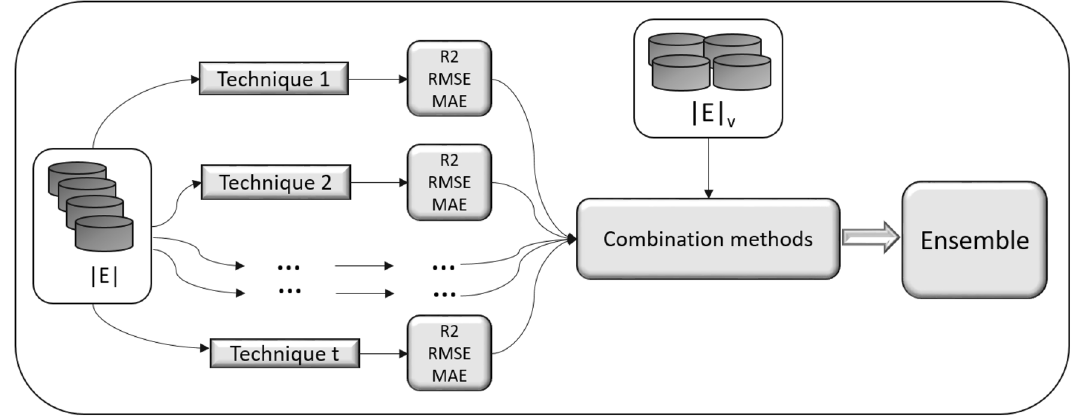
Figure 2. Outline of the proposed ensemble approach.